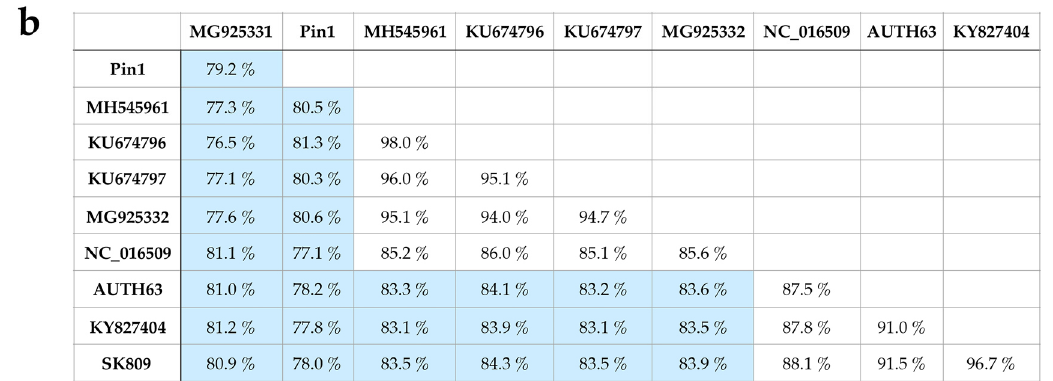
Figure 1. ( a ) Maximum-likelihood phylogenetic tree constructed by MEGA X using the sustitution model GTR + G + I with ten GLRaV-1 complete genomic sequences. Accession numbers and/or isolate names are indicated. The scale bar shows the number of substitutions per site. Bootstrap percentages (1000 resamples) are indicated on the branches. Green dots indicate the new GLRaV-1 genomic sequences obtained in this study. ( b ) Sequence similarity matrix showing the percentages of nucleotide indentity between nearly complete genomes of GLRaV-1 isolates.